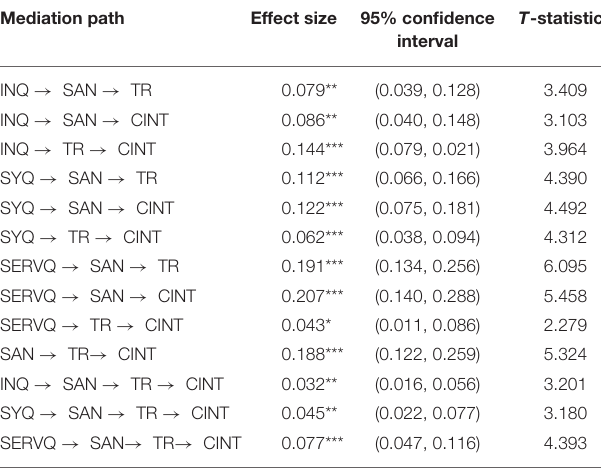
TABLE 7 | Mediation effect